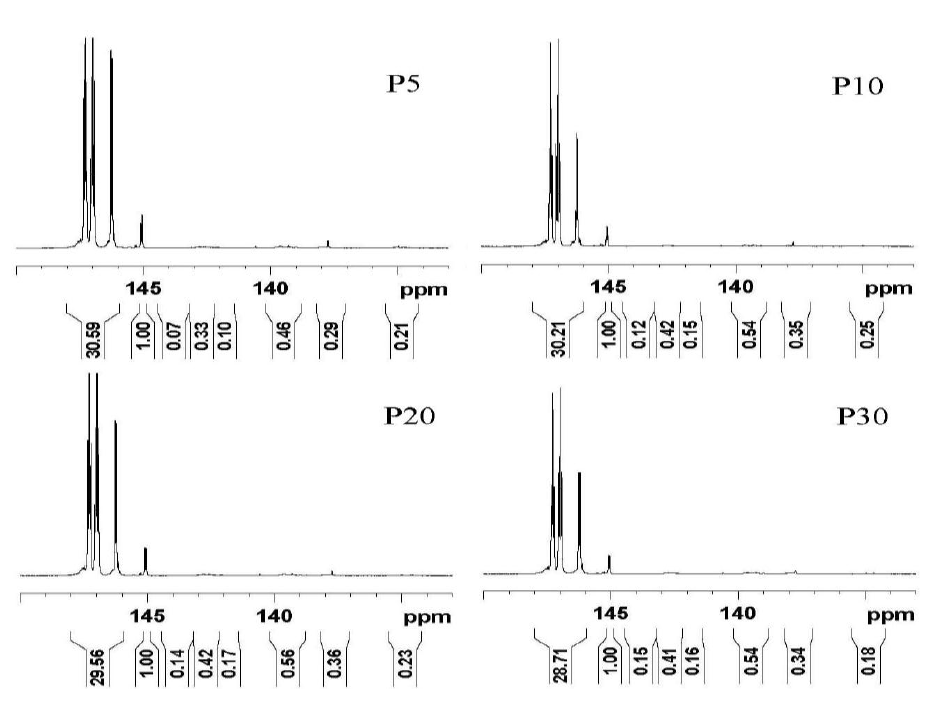
Figure 5. 31 P NMR spectra of all the liquefied